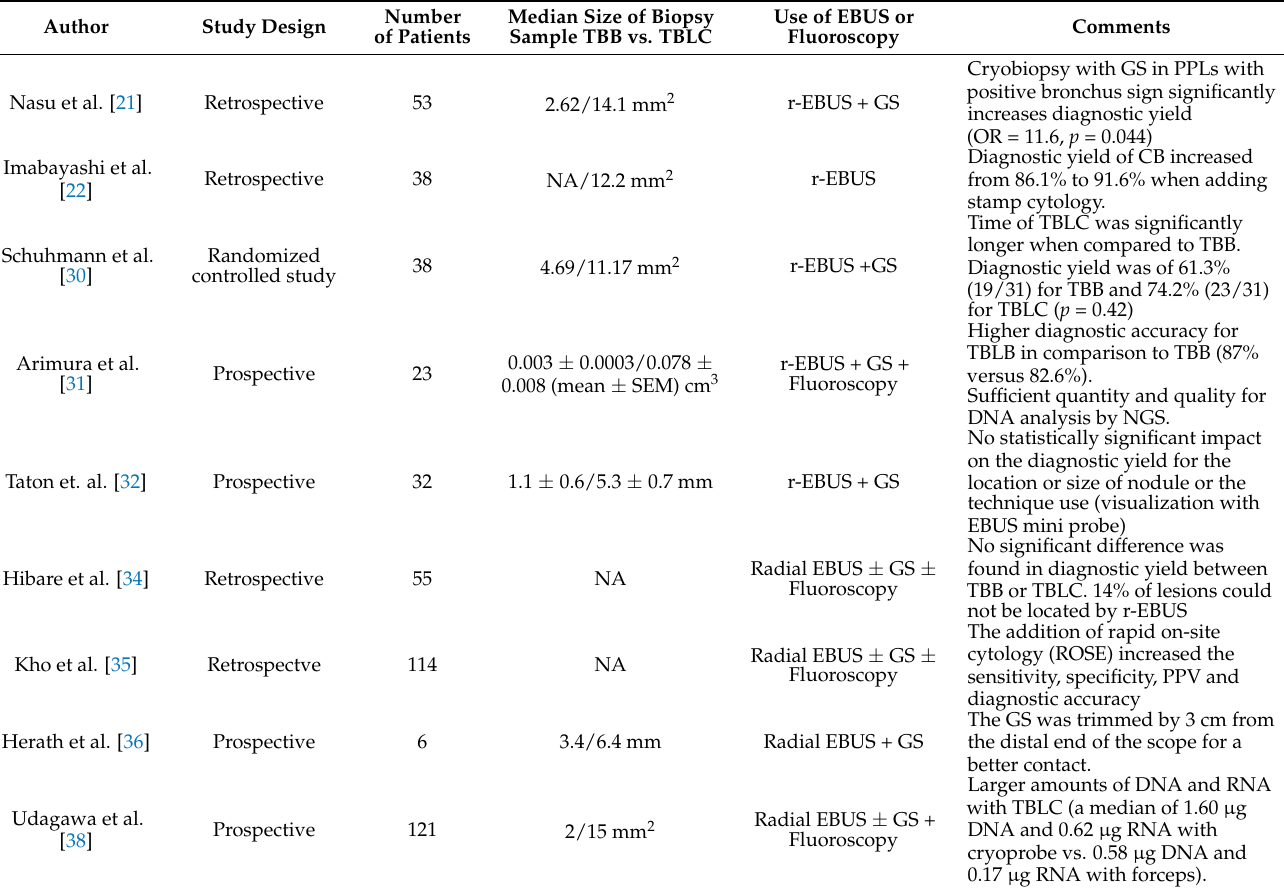
Table 1. Characteristics of the studies describing the value of TBLC and r-EBUS for